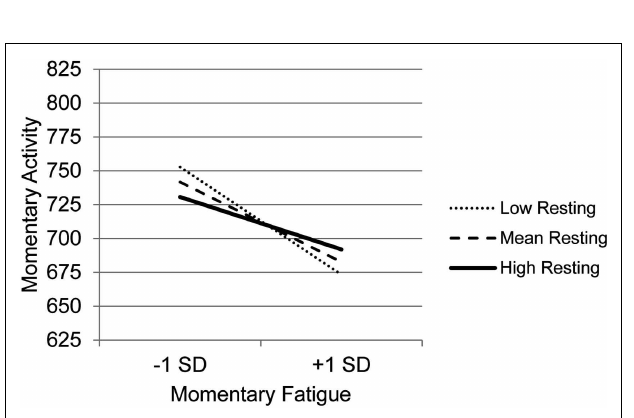
FIGURE 4 | Simple regression slopes for centered momentary fatigue and use of Task Persistence at low, mean, and high levels of momentary physical activity.